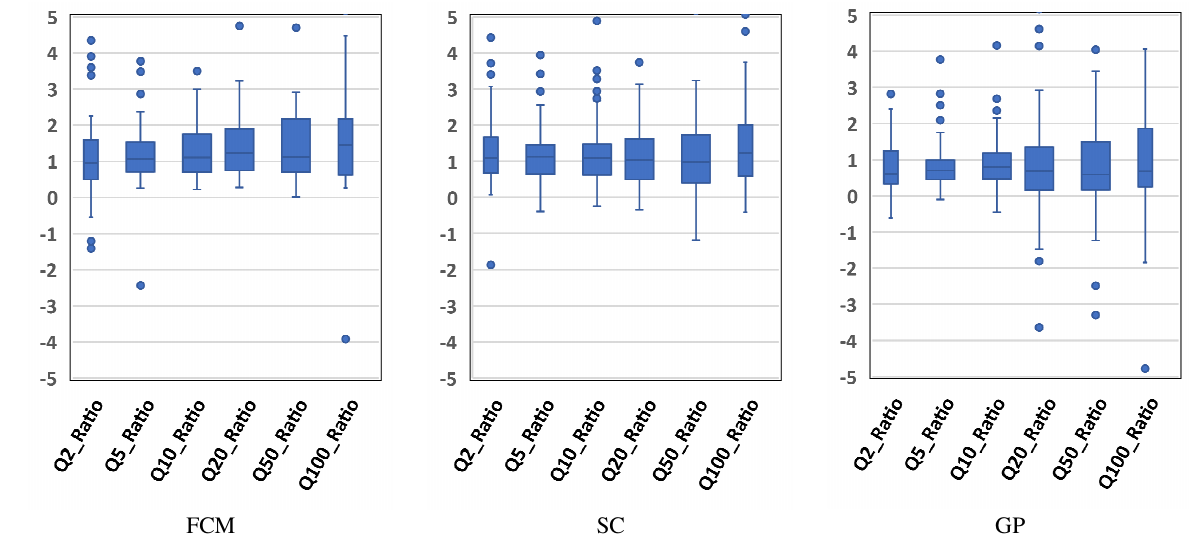
SC GP Figure 4. Boxplots of Qpred / Qobs (Q T _Ratio) values for FCM, SC, and GP models. Figure 4. Boxplots of Qpred / Qobs (Q T _Ratio) values for FCM, SC, and GP Some important evaluation statistics such as REr, Q T _ pred / Q T _obs (median), RRMSE,